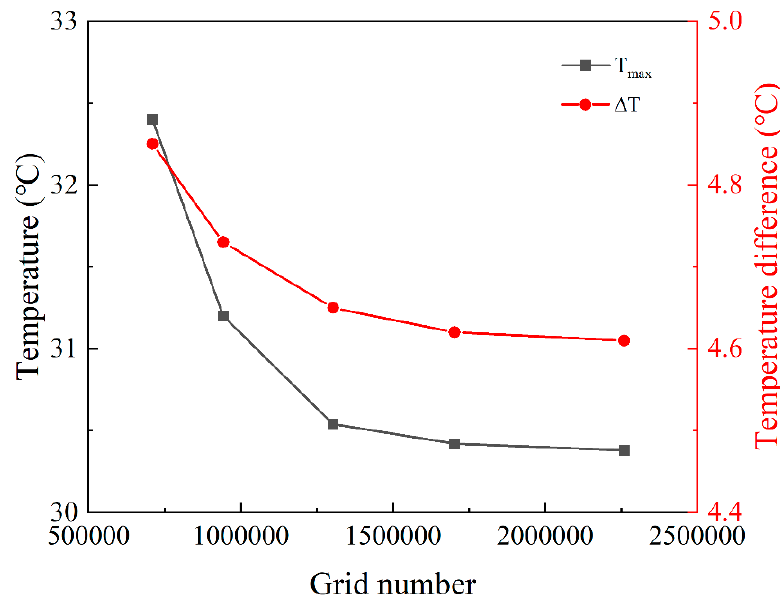
Figure 3. The verification of grid independence. Figure 3. The veri fi cation of grid independence. Table 1. Material thermal property parameters.